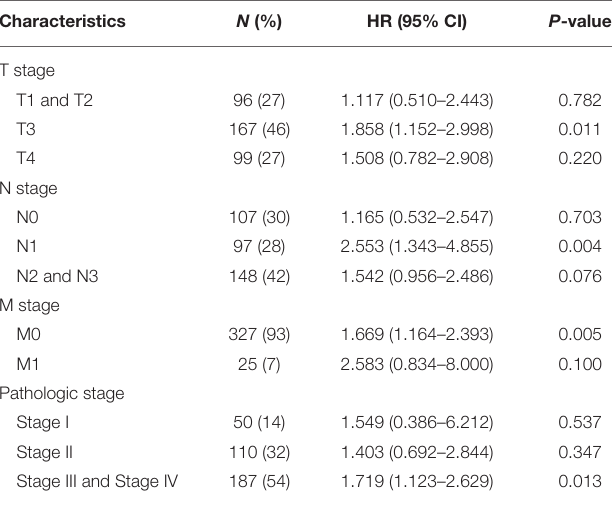
TABLE 6 | Prognostic value for OS of MSC-AS1 for overall survival of STAD subgroups of gastric cancer in TCGA.